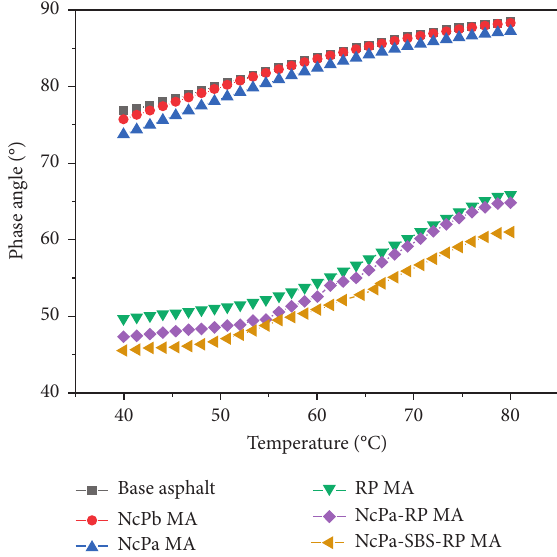
Figure 5: Phase angle versus strain.